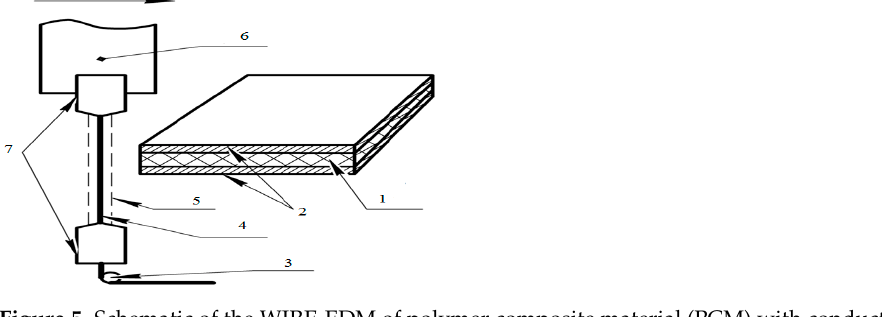
Figure 5. Schematic of the WIRE-EDM of polymer composite material (PCM) with conductive lay- ers used in the present study (1: PCM, 2: conductive Ti-layers, 3: tension roller, 4: ET wire, 5: flushing, 6: gearbox, 7: upper and lower diamond wire